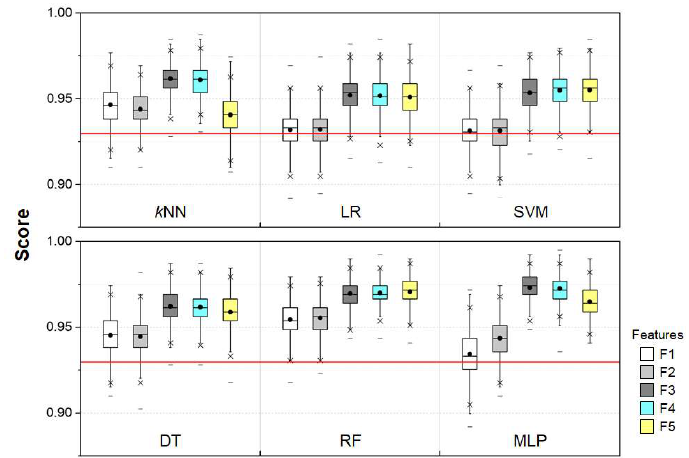
Figure 4. MCS results for the different combinations (F1–F5) of model input features with respect to the classification models. The MCS analysis was performed for the basic precipitation classes (C1). The boxplot describes the distribution of the classification success rate achieved from 1000 realizations. The baseline method indicated by the red solid line was estimated using the two thresholds for critical thickness and surface temperature shown in Figure 3.